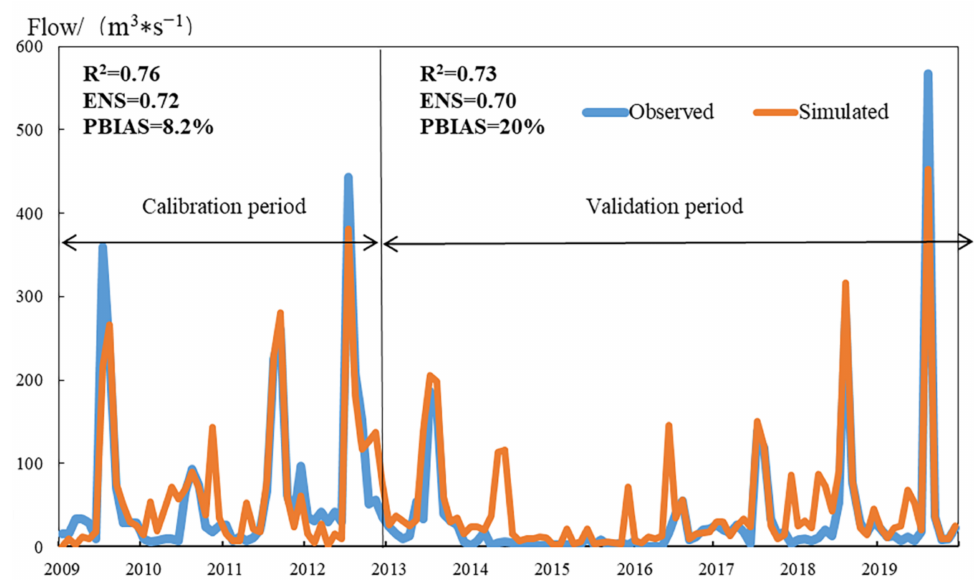
Figure 2. Comparison of the simulated and observed values of monthly runoff in the Yihe River Basin from 2009 to 2019.